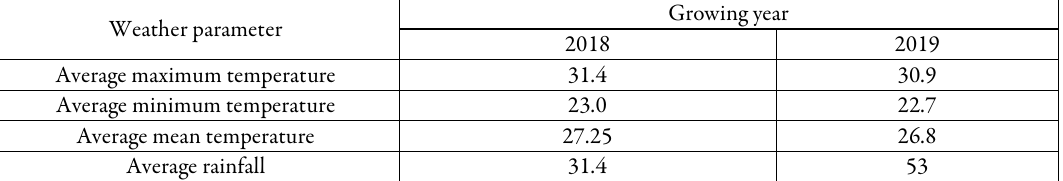
Table 4. Average maximum, minimum and mean temperature (unit ᵒ C), and rainfall (inches) in cropping season (last week of June to mid week of October) of 2018 and